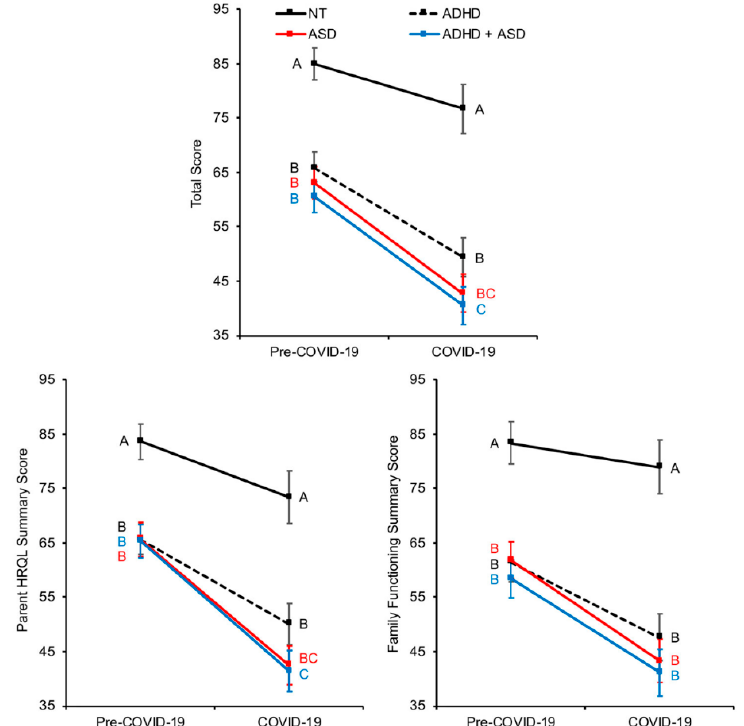
Figure 1. Mean Total Score, Parent HRQL Summary Score, and Family Functioning Summary Score ( ± 95% confidence intervals) pre-COVID-19 and COVID-19 for caregivers of children identified as NT, ADHD, ASD, and comorbid ADHD and ASD. Different letters represent different statistical groupings ( p < 0.05) within each time period. With the exception of Family Functioning for caregivers of NT children, all scores for caregivers within each group of children differed significantly between the two time periods (Table 4). Table 4. Results from the paired t -tests and effect size (Cohen’s d ) calculations before and during COVID-19 for each diagnosis.